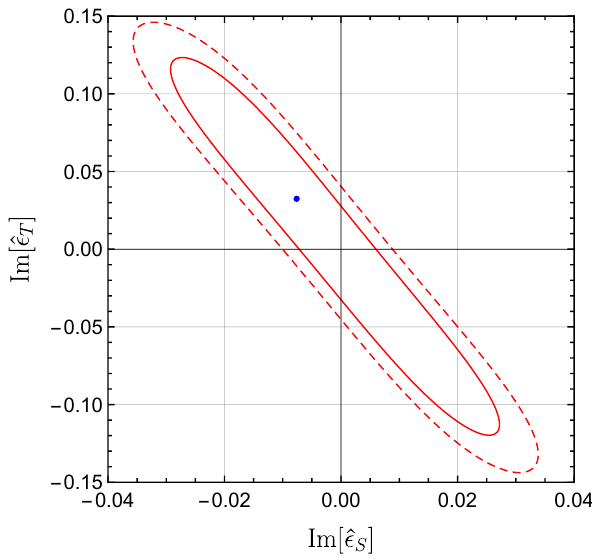
Figure 2 . Allowed regions for the NP parameters Im[ˆ (cid:15) S ] and Im[ˆ (cid:15) T ] at the 68% (region encircled by the red solid curve) and the 90% C.L. (region encircled by the red dashed curve), respectively. The blue point ( − 0 . 008 , 0 . 03) corresponds to the best-fit values of Im[ˆ (cid:15) S ] and Im[ˆ (cid:15) T ]